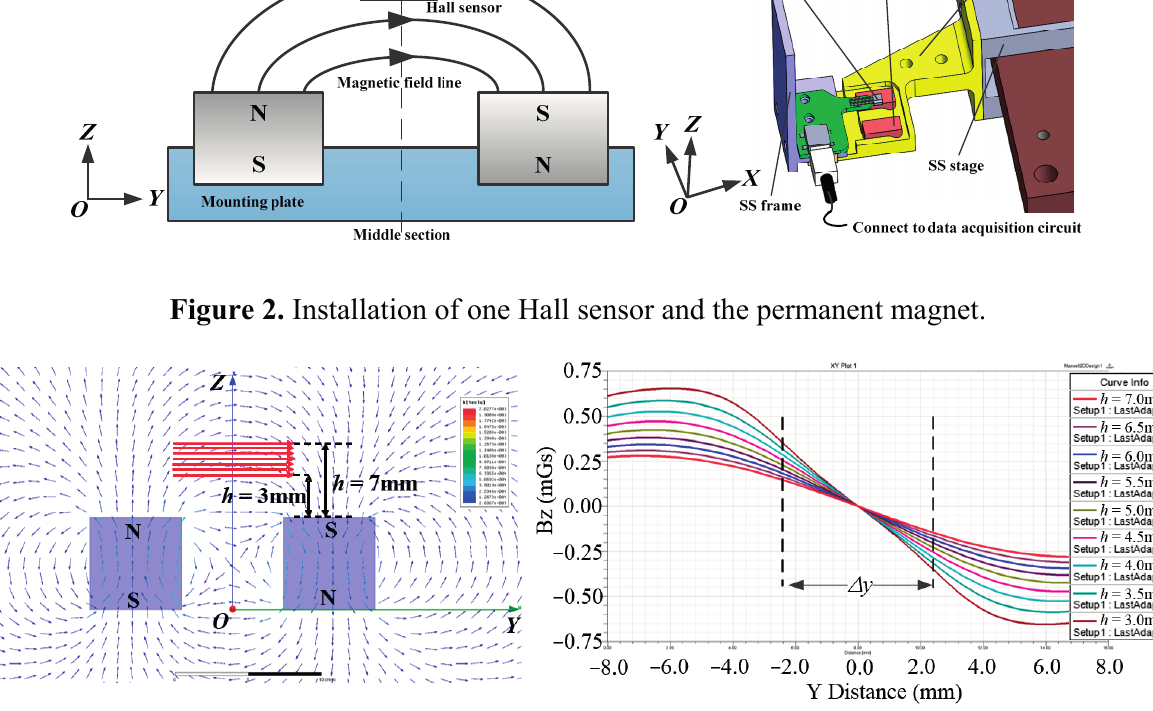
Figure 3. Simulation of the magnetic field, where h represents the height between the Hall sensor and the upper surface of the